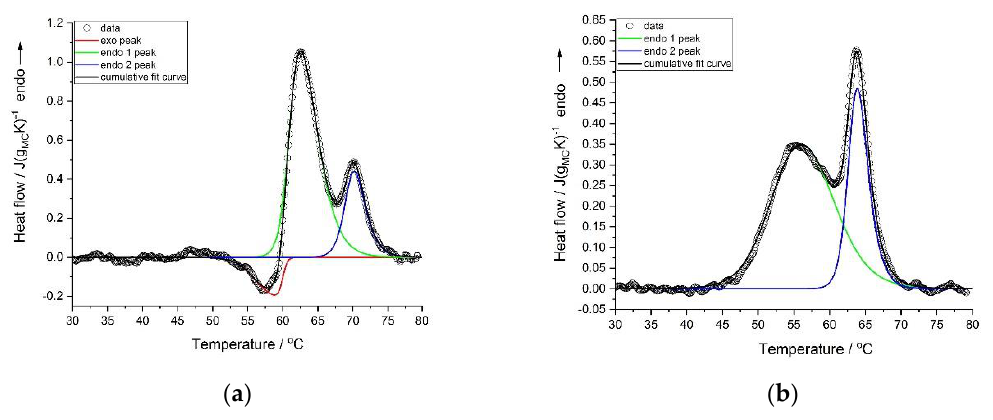
Figure 3. Deconvolution of the thermal effects registered during heating for MC concentrations — ( a ) 1.5 wt.% and ( b ) 9 wt.%.